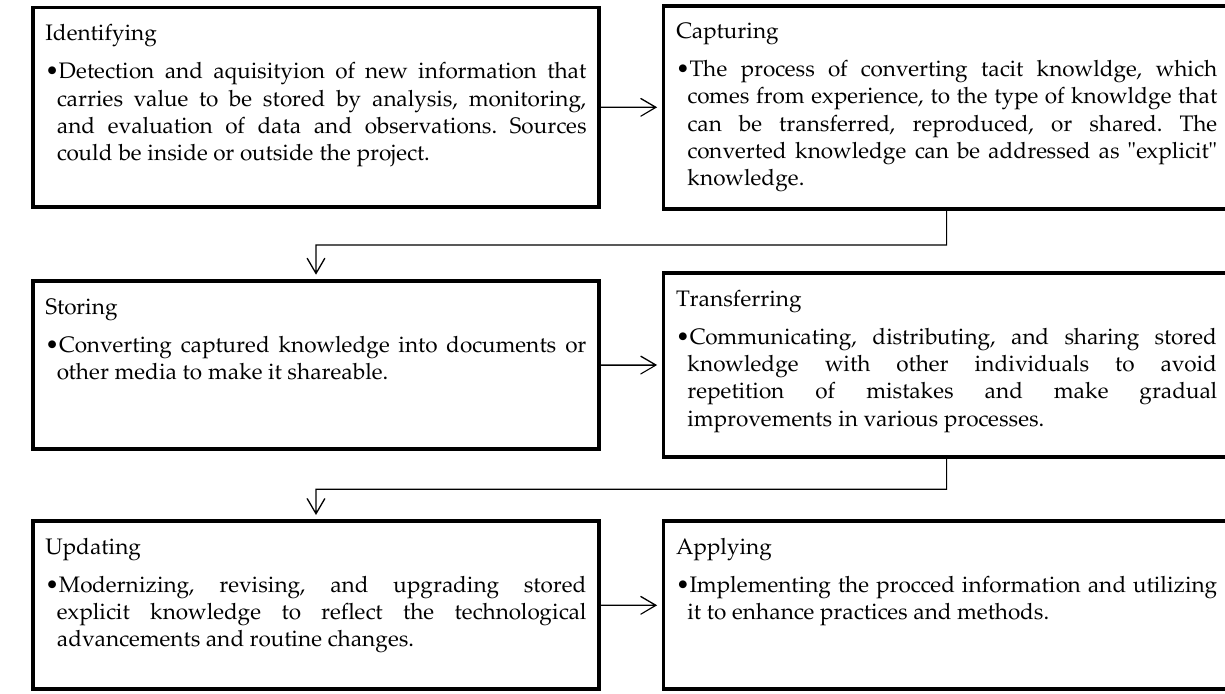
Figure 2. Essential steps for establishing safety knowledge management (adapted from [60]).